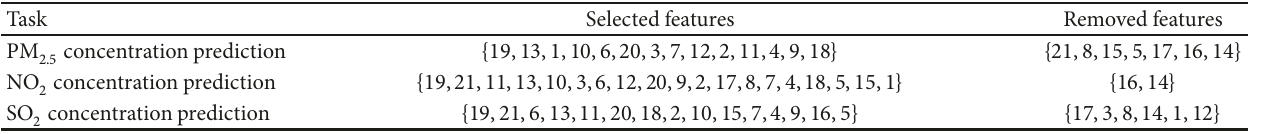
Figure 5: MAE vs. different numbers of selected features on three tasks. Table 2: Selected features relevant to each